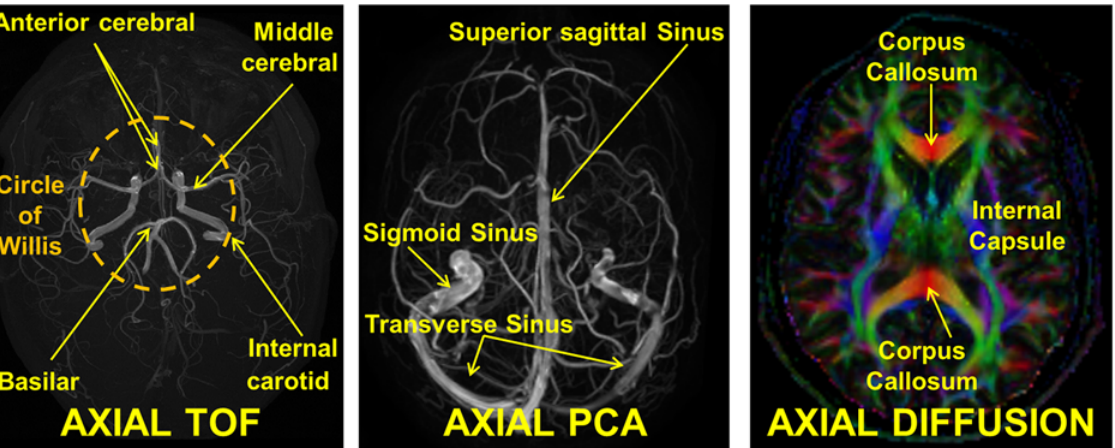
Fig 2. Vasculature information and DTI. Axial view of maximum intensity projection from the 3D TOF (left) and the 3D PCA (middle) MRA. The TOF was optimized to highlight blood flowing in the cranial direction, i.e., mostly arteries, whereas the velocity window of the PCA was chosen such to highlight mostly veins. On the right an axial view of the principal eigenvector map is shown. In the color-coded fiber map, red, green, and blue represent the principal diffusion directions. It is possible to distinguish the corpus callosum in red with its fibers running mostly in left-right direction and the internal capsule bundle in blue with fibers running mostly in superior-inferior direction. Diffusion imaging is not directly used for the segmentation and generation of the anatomical model, but it provides anisotropic electrical properties of the tissues for electromagnetic applications and nerve orientation.